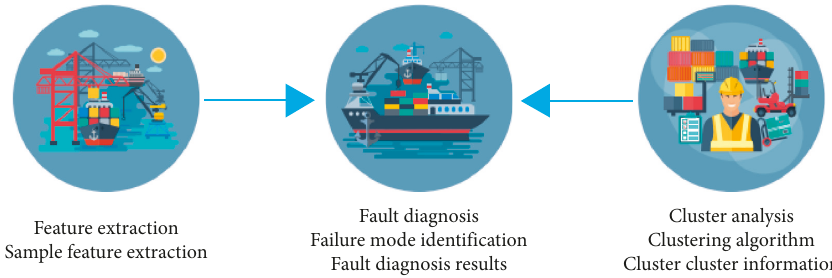
Figure 2: Fault diagnosis model of port machinery based on